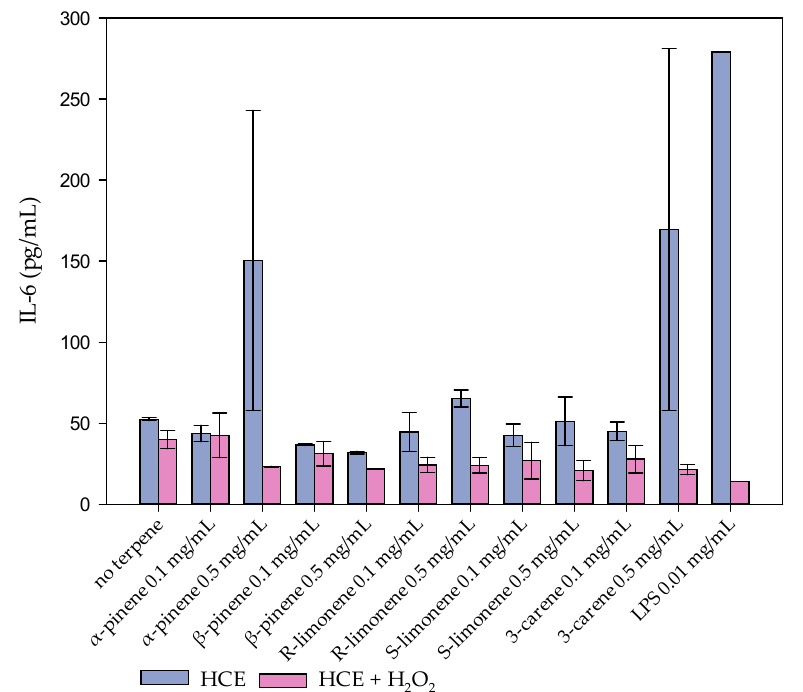
Figure 3. The oxidative stress-protective effect of α - and β -pinene, R- and S-limonene, and 3-carene with two different concentrations (0.1 and 0.5 mg/mL) in the HCE cell model. The values represent the average and range of the HCE cell viability (%) (sample size = 2) without (light blue bars) and with (light red bars) hydrogen peroxide (800 µM H 2 O 2 ) treatment. Monoterpenes did not show a clear oxidative stress-protection for the HCE cell cultures. The inflammation marker protein IL-6 production was measured at two different ex- posure times from the cell culture media (Figure 4). At the concentration 0.5 mg/mL, α - pinene and 3-carene induced a strong IL-6 production, which indicated a similar inflam- mation response as caused by lipopolysaccharide (LPS) used as a positive control. The other terpenes had no effect on IL-6 production of the HCE cells. The strong H 2 O 2 treat- ment with or without monoterpenes did not affect the IL-6 production either, probably because the dose was lethal (Figure S1) [30].